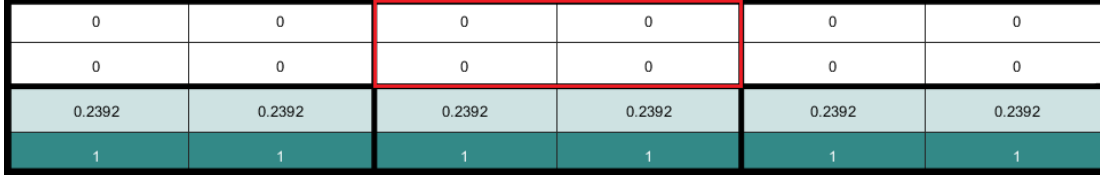
Figure 12. Subdivision for the grid Box G for the second